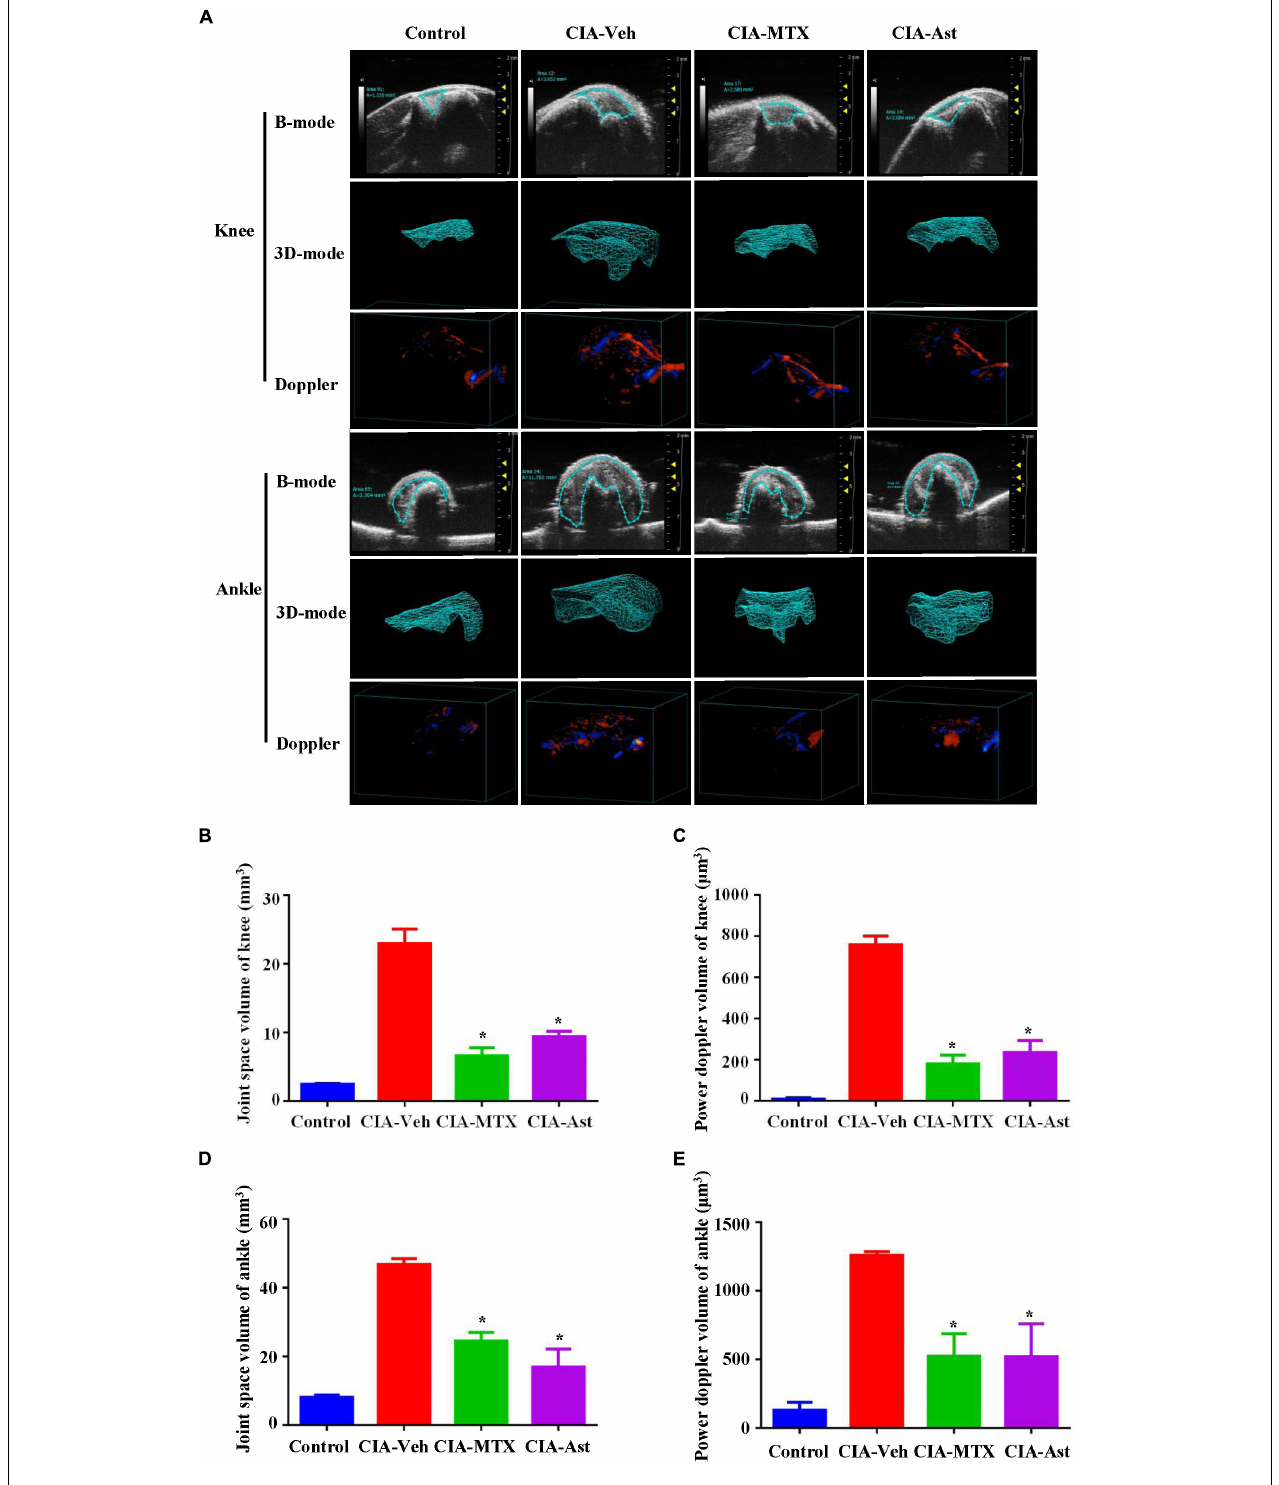
FIGURE 2 | Astragalin inhibited joint space widening and synovial vascularity. After 7 weeks of treatment, the knee joints and the ankle joints (A) were analyzed using the Vevo 2100 imaging system in both B mode and color doppler mode. 3D reconstructions of knee and ankle joints using the Vevo LAB software, which allowed for accurate volume measurement of the joint space widening and synovial vascularity (B–E) . Data are shown as mean ± SEM of four mice per group, ∗ p < 0.05, ∗∗ p < 0.01 versus CIA-Veh group.